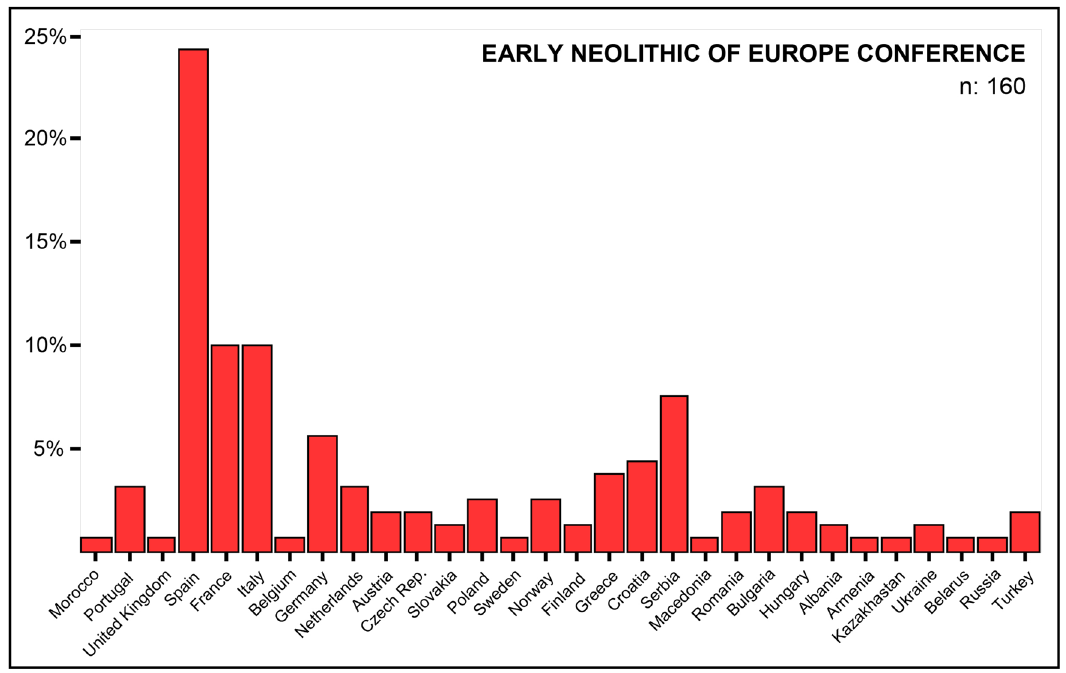
Figure 3: Breakdown by countries of the geographical regions covered by both oral and poster presentations given at the Early Neolithic of Europe conference.